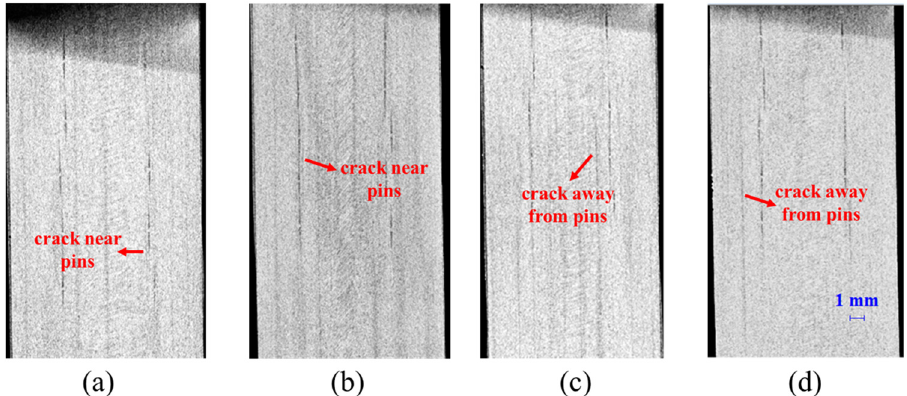
Figure 6: Microscopic morphology at di ff erent locations through the second direction of composite reinforced by 0.1 mm Z - pin after moisture coupled with fl exural load for 7 days. ( a and b ) Show crack near pins; ( c and d ) show crack away from pins.